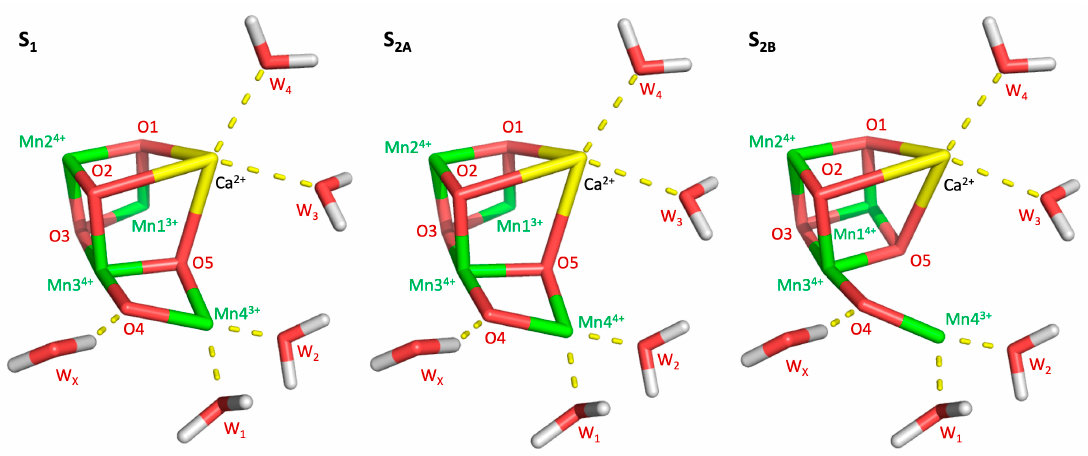
Figure 1. Manganese oxidation of the S-states examined in this work (S 1 , S 2A , and S 2B ), as well as the placement of relevant waters .